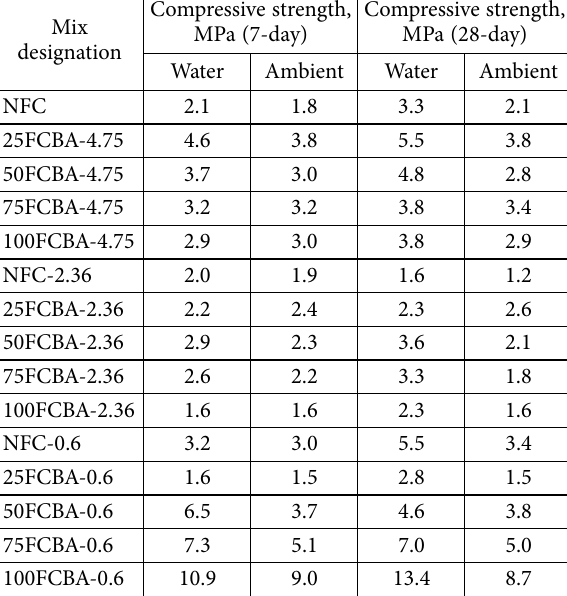
Table 6. Compressive strength of 7- and